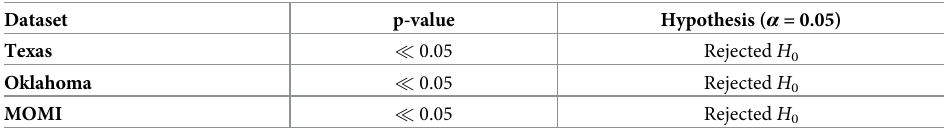
Table 19. Kruskal-Wallis test for all three datasets.